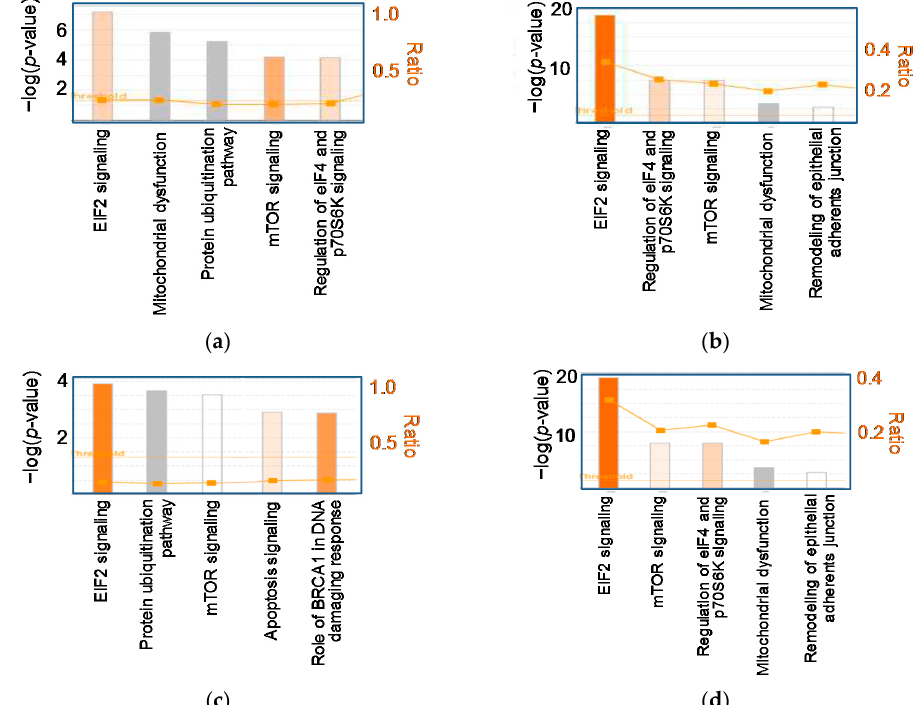
Figure 2. The top five canonical pathways of hepatic genes that were significantly altered by astaxanthin ( a , c ); or vitamin E ( b , d ) in mice with CL diet-induced nonalcoholic steatohepatitis; ( a , b ) Canonical pathways of genes that were significantly up- or downregulated by astaxanthin ( n = 1137) and vitamin E ( n = 1397), respectively; ( c , d ) Canonical pathways of genes whose expressions were significantly improved by astaxanthin ( n = 738) and vitamin E ( n = 1330), respectively. The most significant pathways in the dataset were identified by Ingenuity Pathway Analysis. Orange bars indicate predicted pathway activation. White bars indicate pathways not predicted to be activated or inhibited. Gray bars indicate pathways where no prediction had been made. Orange points connected by lines represent the ratio of the number of genes in a given pathway to the total number of genes in the reference set that make up that pathway. EIF2, eukaryotic initiation factor-2; mTOR, mammalian target of rapamycin.